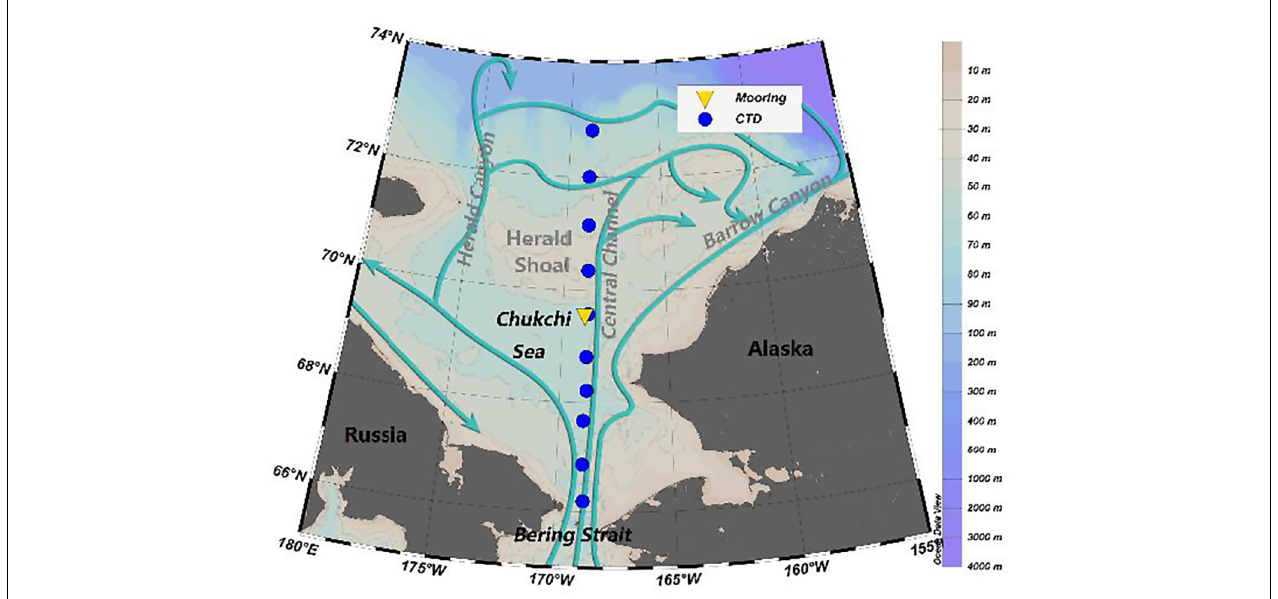
FIGURE 1 | Bathymetry, mooring and CTD stations in the Chukchi Sea during